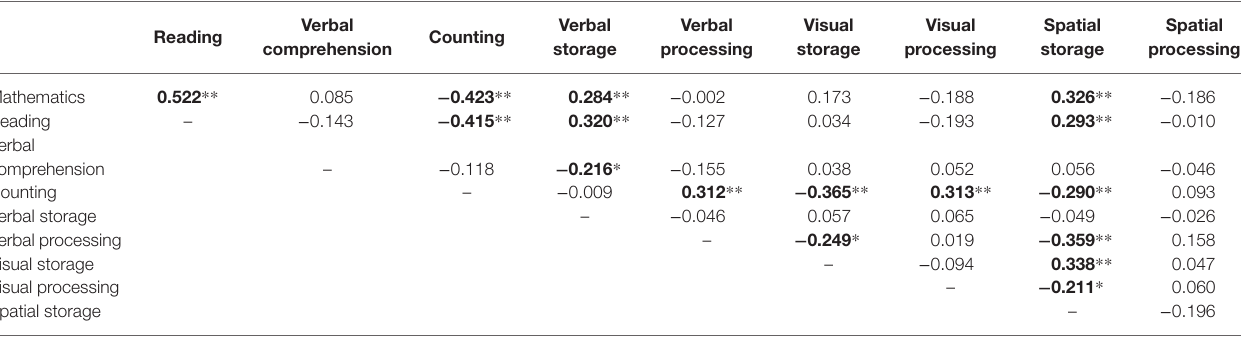
TABLE 4 | Correlation between all cognitive and academic